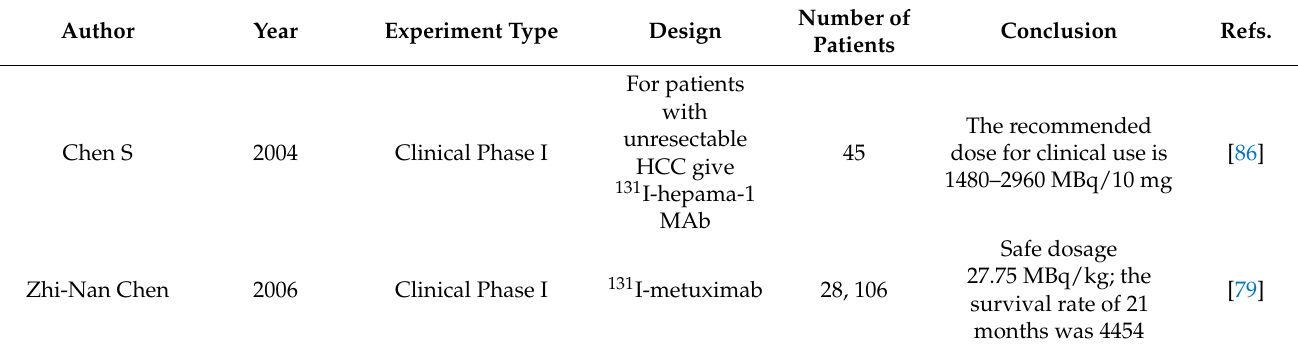
Table 6. Advances in radioimmunotherapy for the treatment of